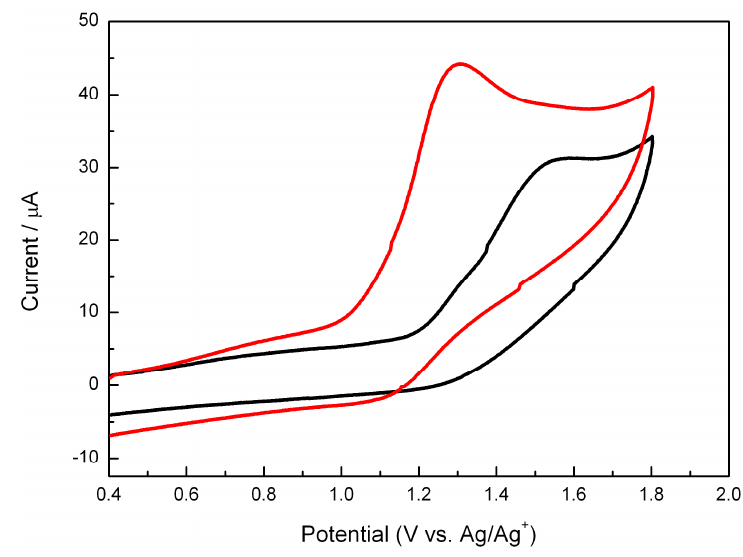
Figure 4. Cyclic voltammograms of 2a (red line, 1 mM) and 2b (black line, 1 mM) in acetonitrile using 0.1 M Bu 4 NClO 4 as electrolyte. Scan rate: 0.5 V·s − 1 .